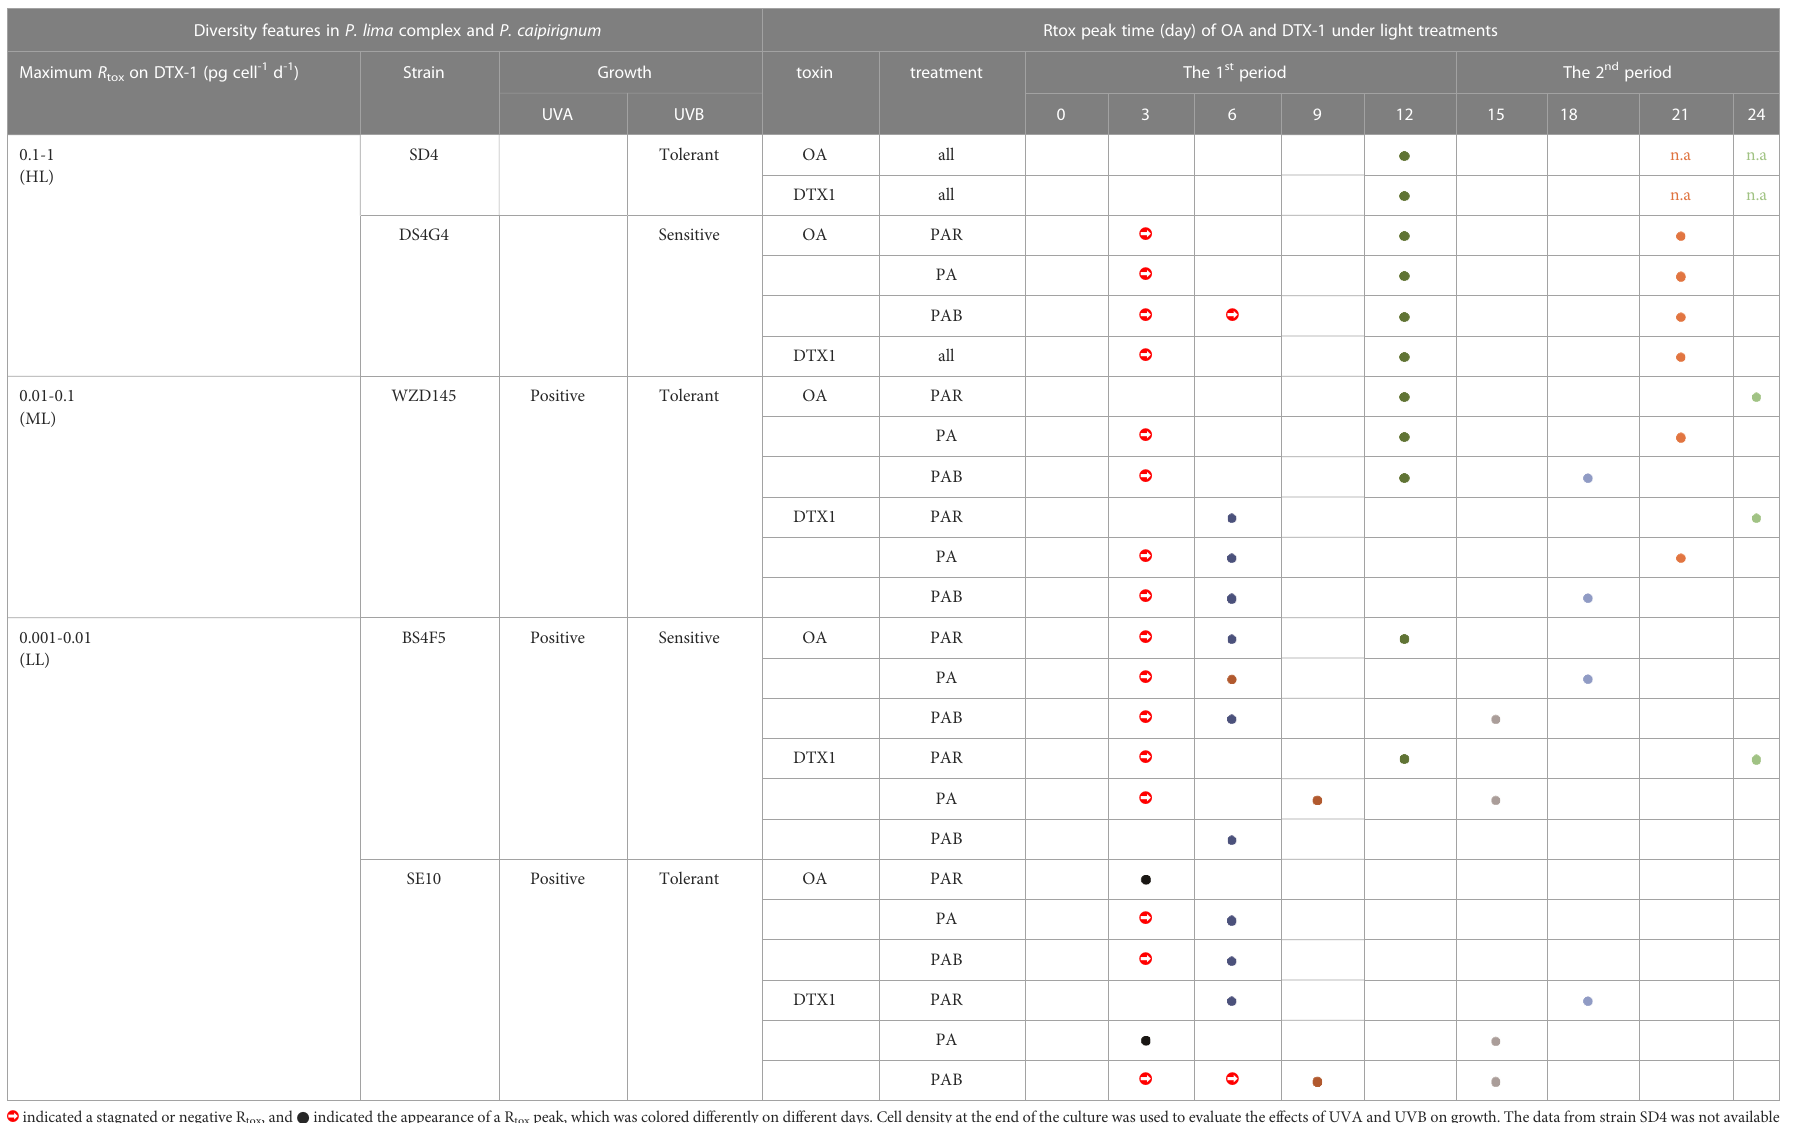
➲ indicatedastagnatedornegativeR ● indicatedtheappearanceofaR tox ,and tox peak,whichwascoloreddifferentlyondifferentdays.CelldensityattheendoftheculturewasusedtoevaluatetheeffectsofUVAandUVBongrowth.ThedatafromstrainSD4wasnotavailable (n/a) on days 21 and